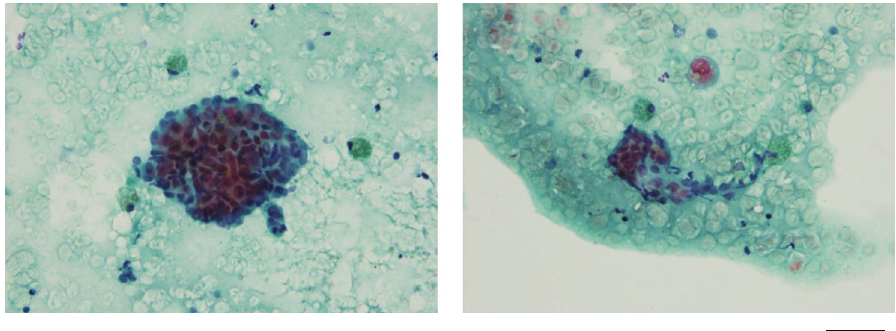
Figure 2: The specimens of fine needle aspiration biopsy. Bar: 100 𝜇